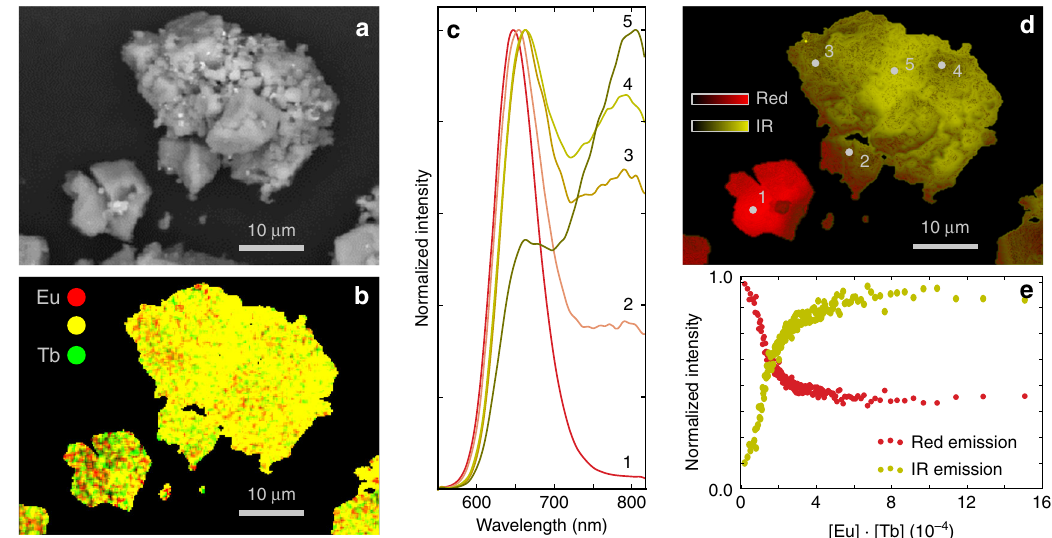
Fig. 3 Microscopic SEM-EDX-CL study. Scanning electron microscope (SEM) study on a CaS:Eu 0.01 Tb 0.01 powder. Backscattered electron image ( a ), along with energy-dispersive X-ray (EDX) maps for terbium and europium ( b ). The colors encode the local terbium (green) and europium (red) concentrations. Simultaneous detection leads to a yellow color. c Cathodoluminescence (CL) spectra for a few selected points that are indicated in d . d False color image, displaying the total integrated CL intensity. e shows how the relative contributions of the red Eu 2 + (integrated from 600 to 650 m) and IR (integrated from 760 to 815 m) luminescence band to the total CL spectrum evolve as a function of the local Eu and Tb concentrations, [Eu] ⋅ [Tb].